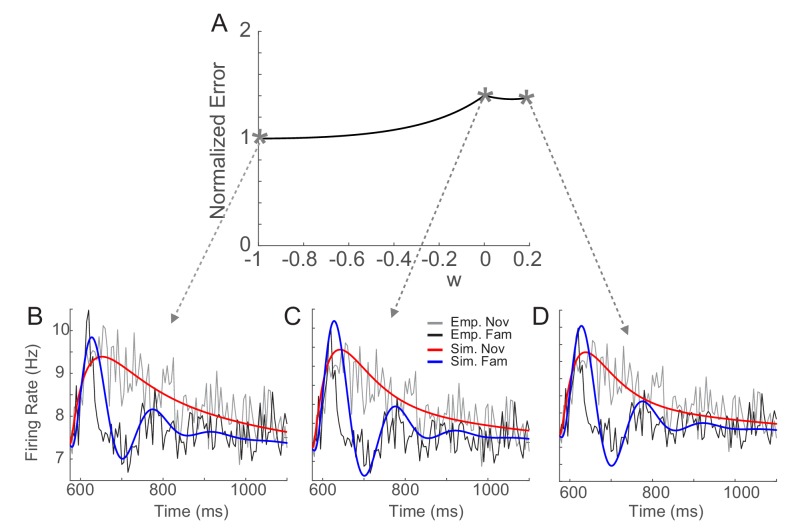
Sensitivity of fitting to changes in the recurrent connectivity strength before learning, wR.(A) The distance between the data and simulation of the response for familiar stimuli normalized by the lowest distance as in Figure 5—figure supplement 2. (B–D) Comparison between the data and network simulations for different wR. For a wide range of wR, the simulation fit the data well. The parameters are the same as in those in Figure 5 except a, b, t0, and t1 which were adjusted for each wR to reproduce response to novel stimuli.